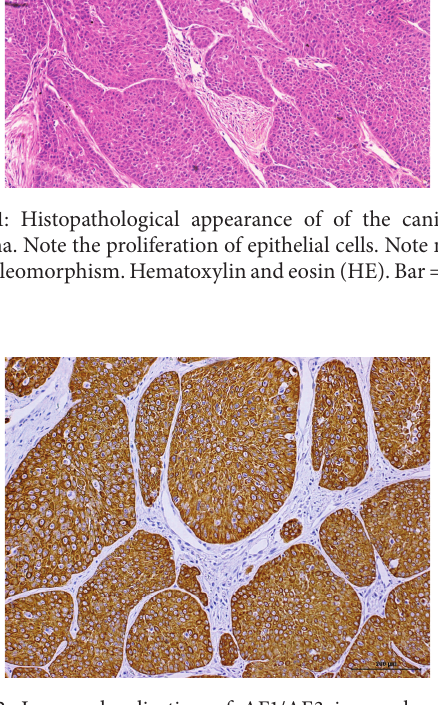
Figure 4: Immunolocalization of COX-2 in nasal carcinoma before treatment. Positive signal can be observed as the brown color in the cytoplasm of the cells or in the cytoplasm with hematoxylin counterstain. Bar = 50 𝜇